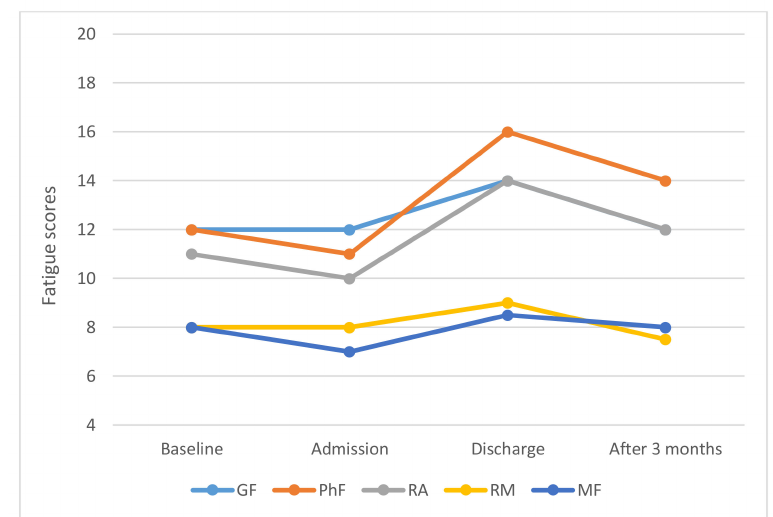
Figure 1. The fatigue trajectory of the wholegroup of allogeneic haematopoietic stem celltransplantation (allo-HSCT) patients shown by the median levels. GF, General Fatigue; PhF, Physical Fatigue; RA, Reduced Activity; RM, Reduced Motivation and MF, Mental Fatigue (range 4–20).